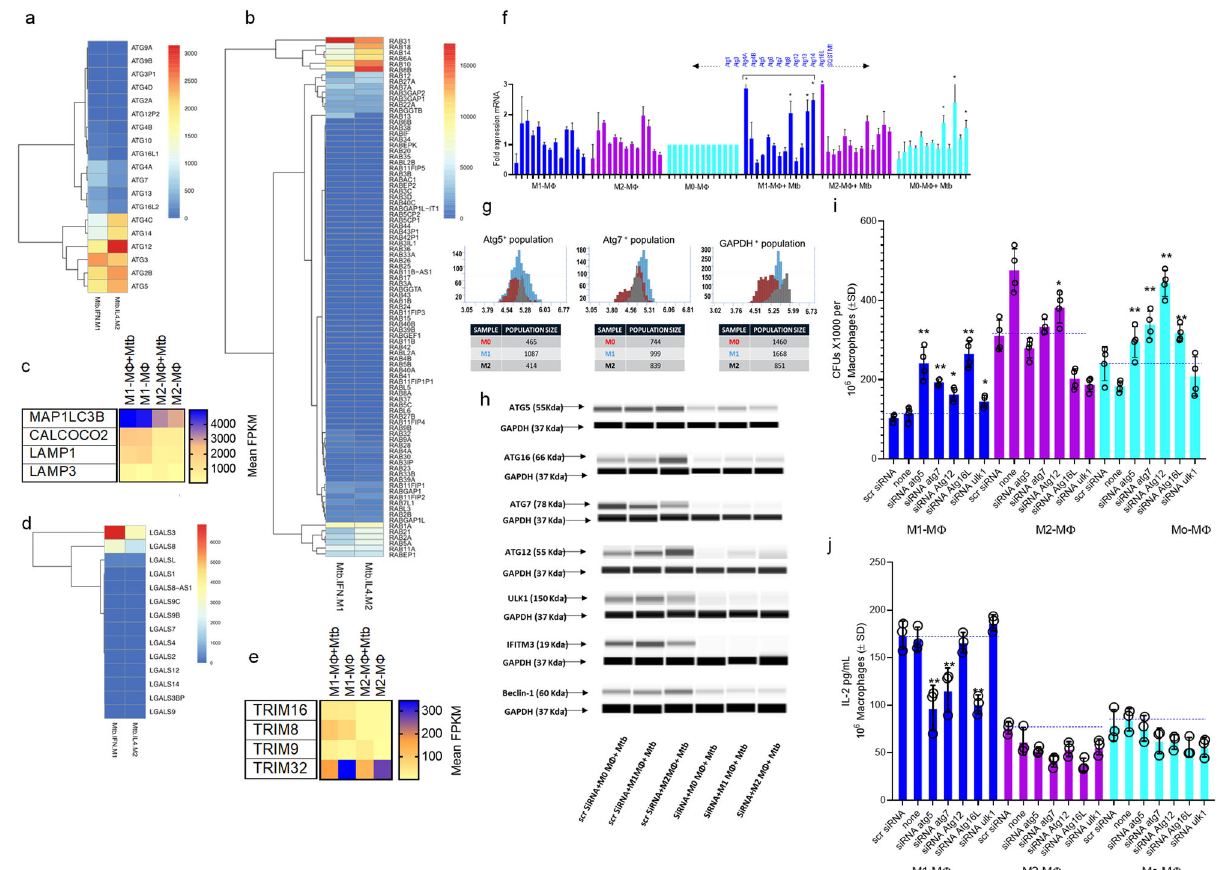
Fig. 3 Mtb-infected human M1-, M2-, and M0-M Φ s show differential expression of autophagy-regulating ATGs, RAB GTPases , Galectins ( LGALS ) and Tripartite-containing motif protein ( TRIM ) encoding accessory genes. a – e CBM-derived M1-, M2-, and M0-M Φ s were subjected to RNAseq before and after Mtb infection as in Fig. 2 at 18 h post Mtb infection. Data are shown for M1- vs. M2-M Φ s and transcripts are shown as FPKMs (fragments per kilobase per million reads) for gene clusters ( n = 2). f Quantitative PCR analysis for autophagy-regulating genes ( ATGs ) at 18 h (Mtb-infected vs. naive; * p < 0.01, t test, n = 2; one of 2 similar experiments). g Single cells of uninfected M1-, M2-, and M0-M Φ s were dispensed into the wells of the MILO single-cell protein pro fi ler. ATG5 and ATG7 proteins with a GAPDH control were detected using speci fi c antibodies and in situ western blot; quantitation of the number of M Φ s expressing proteins are shown. h Mtb-infected or naïve M1-, M2-, and M0-M Φ s were analyzed for ATG proteins before and after siRNA knockdown including beclin1 ( ATG6 ) (Origene, USA) (one of 2 similar experiments shown). Densitometry is shown in Supplementary Fig. 8. i Indicated ATGs were knocked down using speci fi c duplexes of siRNA (Origene, USA), followed by infection with Mtb and CFU counts on day 3 maintaining >90% viability of M Φ s. Baseline CFUs of scrambled siRNA controls are shown by a dotted line (one of 3 experiments shown). j siRNA or scrambled siRNA treated replicates of M Φ s from panel i were overlaid with an Ag85B-derived epitope-speci fi c F9A6-CD4 T cell line for antigen presentation. IL-2 was measured in supernatants using sandwich enzyme-linked immunoassay at 18 h (one of 2 independent experiments shown). Baseline antigen presentation by scrambled siRNA controls is shown by a dotted line. Panels ( i , j ): ** p < 0.007; * p < 0.009 one-way ANOVA with Tukey ’ s test. All Mtb CFU experiments used MOI of